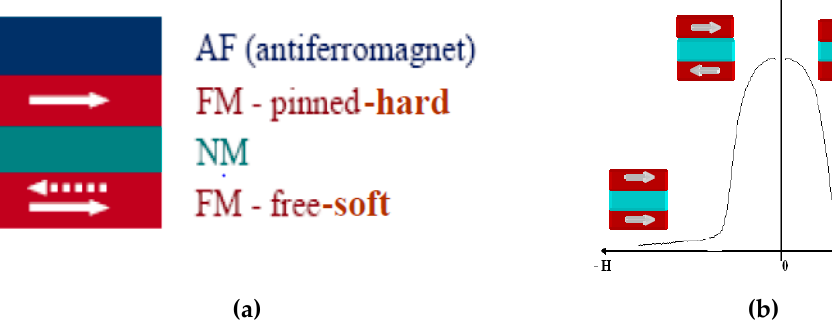
Figure 4. ( a ) Stacking sequence of the magnetic and non-magnetic layers in a giant magneto resistive (GMR) sensor, the dotted arrow stands for the antiparallel magnetization axis with respect to the hard layer; ( b ) the electrical resistance variation ∆ R/R as function of an external applied magnetic field H.